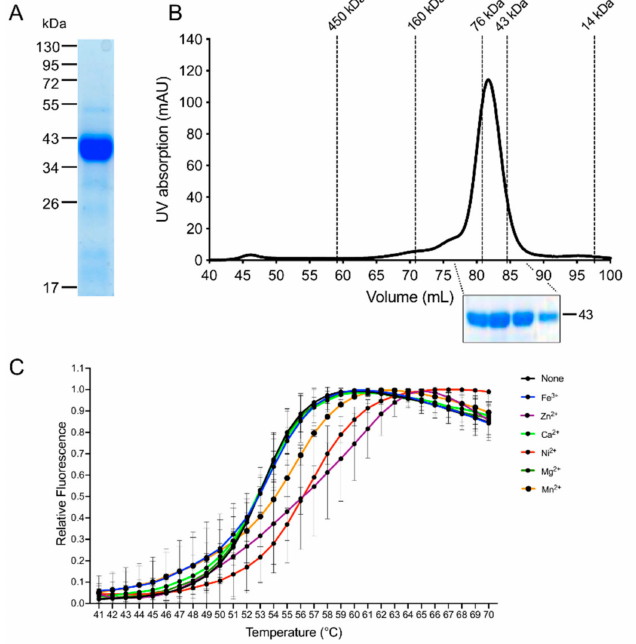
Figure 3. Recombinant expression, investigation of the oligomeric state and putative metal cofactor binding of EhADH3B b . ( A ). ehadh3b b was recombinantly expressed in E. coli as a GST-fusion protein and purified using a ffi nity chromatography. After purification and cleavage of the GST tag, the recombinant ADH3B b (recADH3B b ) can be displayed as a 43 kDa protein band after SDS-PAGE and Coomassie staining. ( B ). Size exclusion chromatography of recADH3B b was performed on a